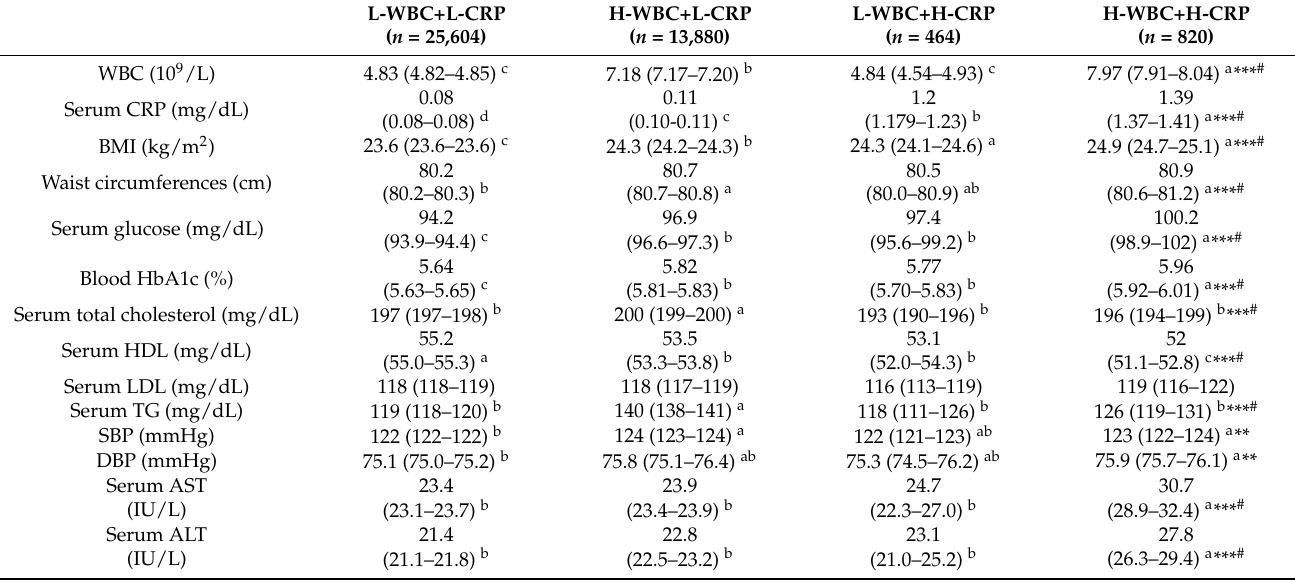
Table 2. Adjusted means and 95% confidence intervals of metabolic syndrome-related parameters according to immunity